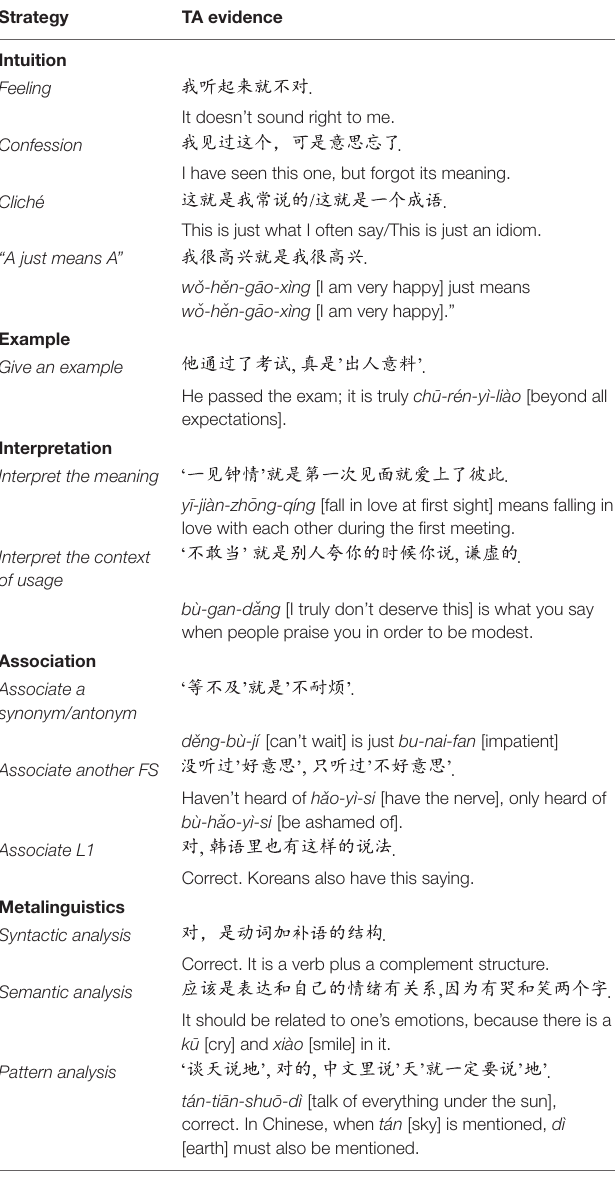
TABLE 2 | Processing strategies, specific presentations, and TA evidence.